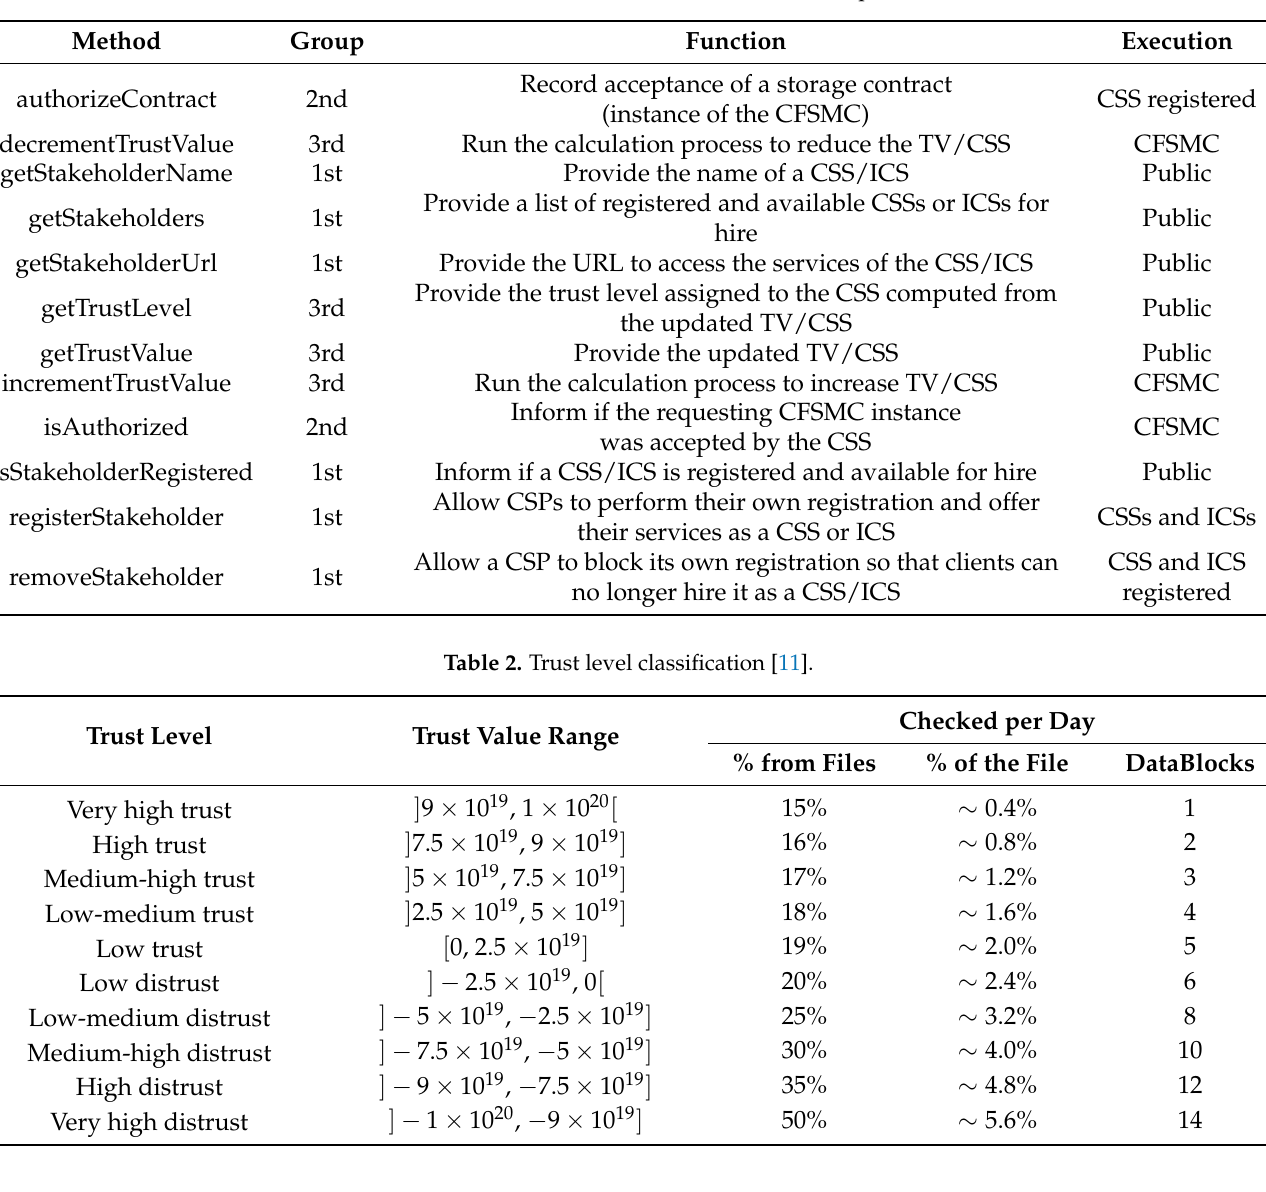
Table 1. Functions of SSTMC methods and the roles that can perform them.